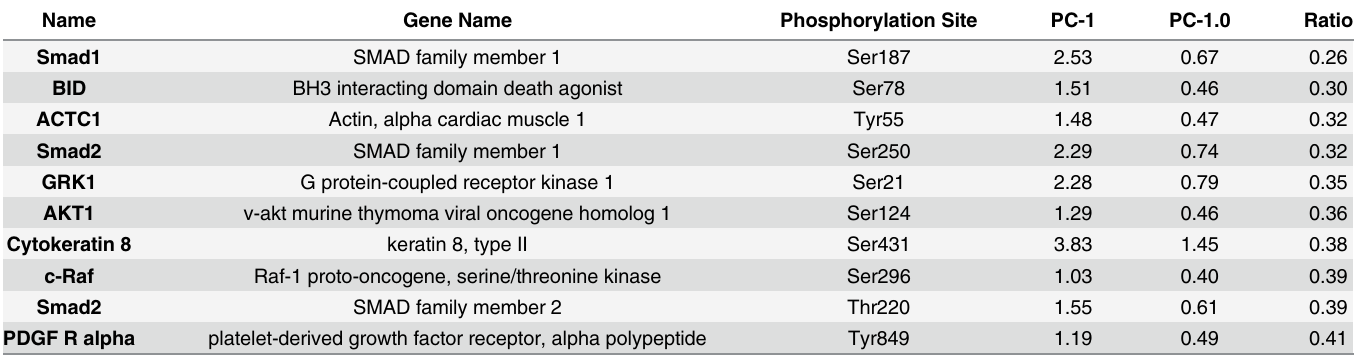
Table 2. The top ten down-regulated genes in highly invasive and metastatic cells (PC-1.0) compared with weakly invasive and metastatic cells